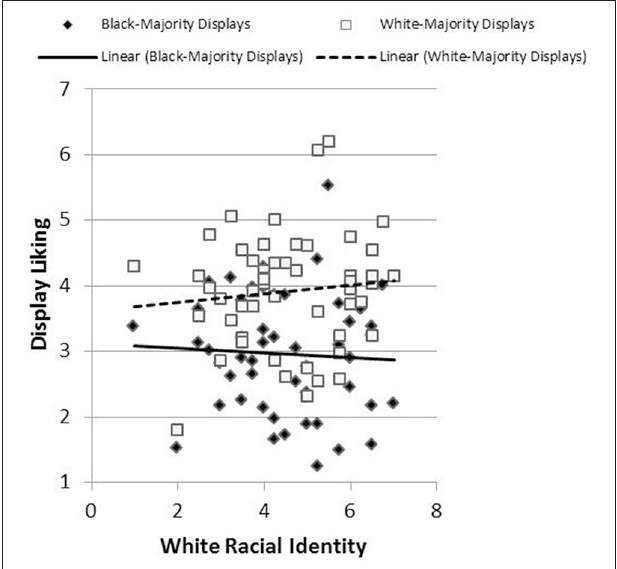
FIGURE 6 | Relationship between racial identity and display liking among Black-Majority and White-Majority Black History displays, Study 2.